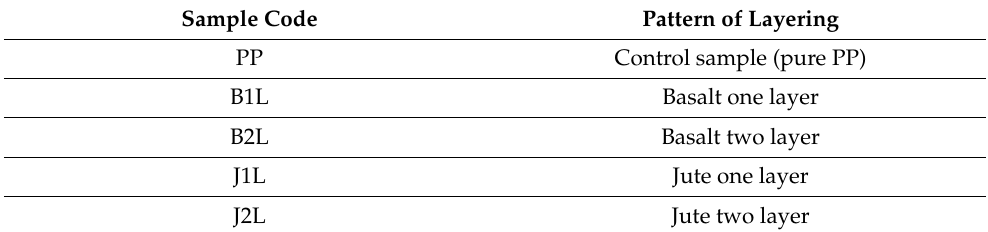
Table 3 shows the list of samples and their codes. Table 3. The samples developed.